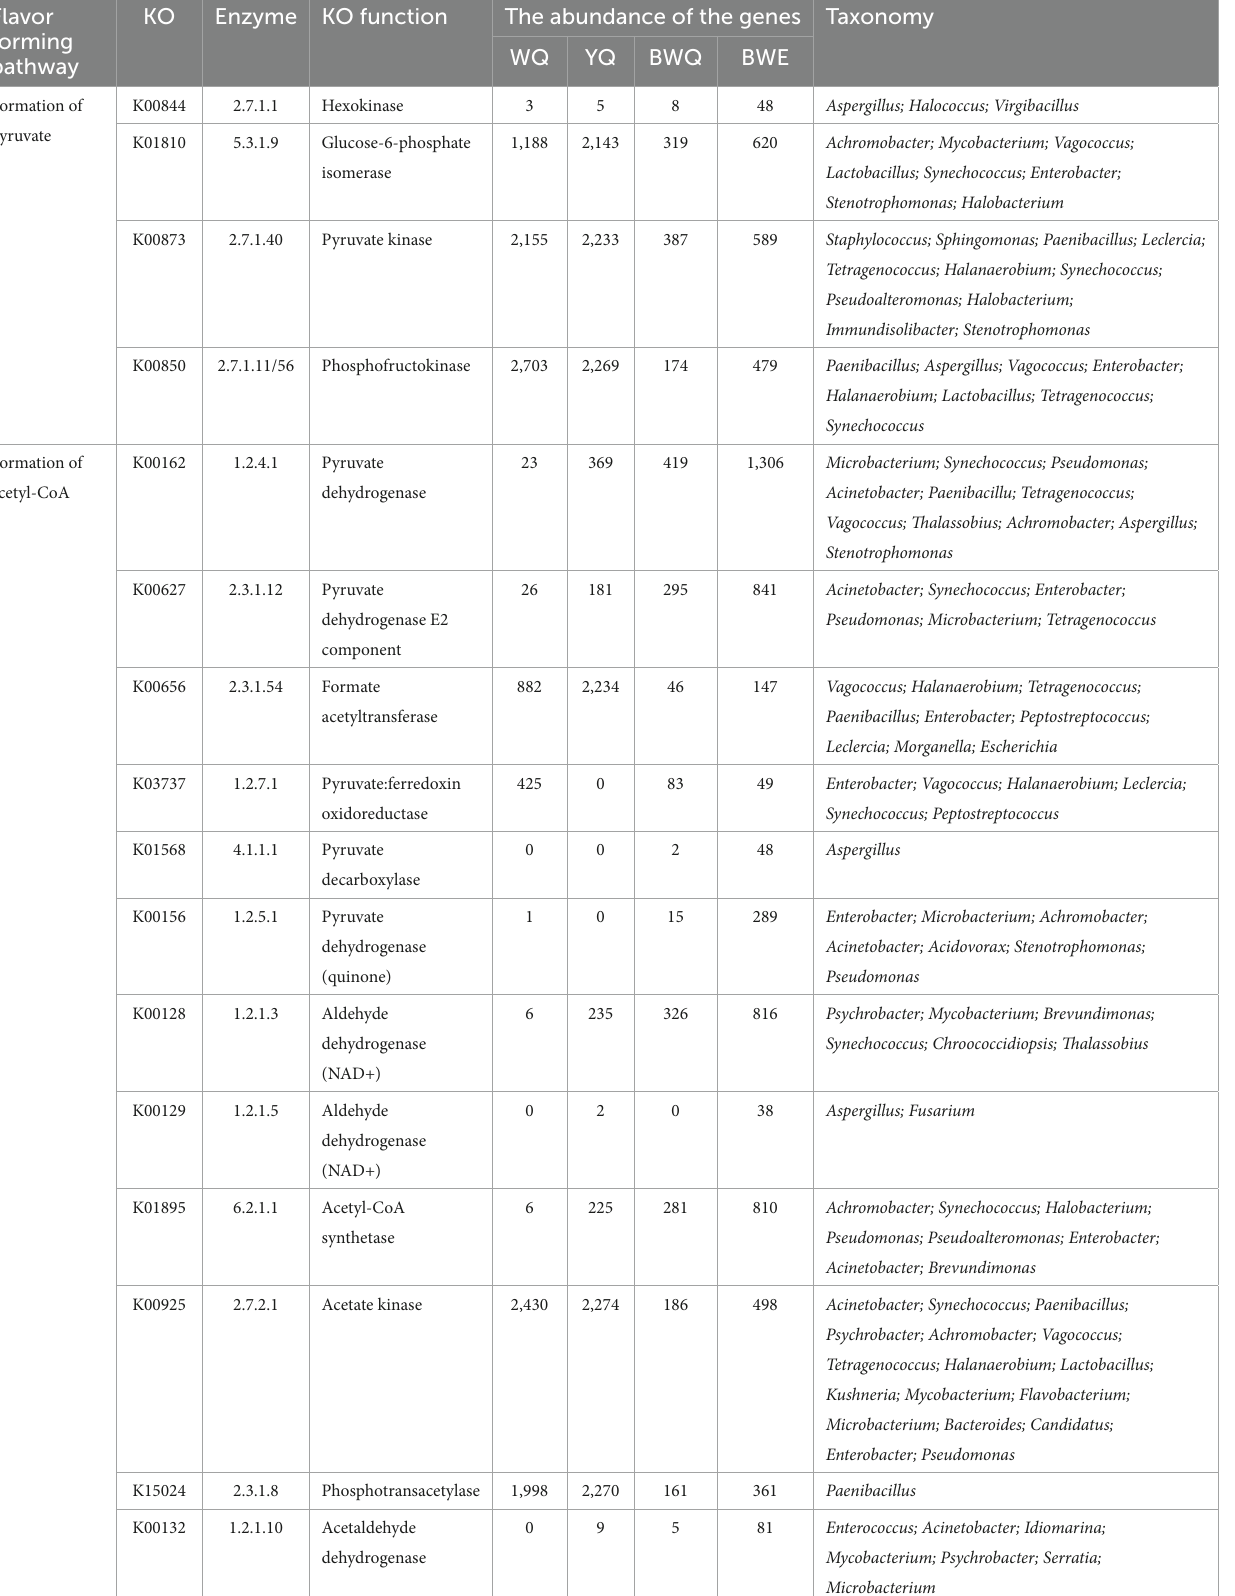
TABLE 2 Flavor metabolism-related enzymes, gene abundance and microbial distribution of fish sauces. Flavor forming